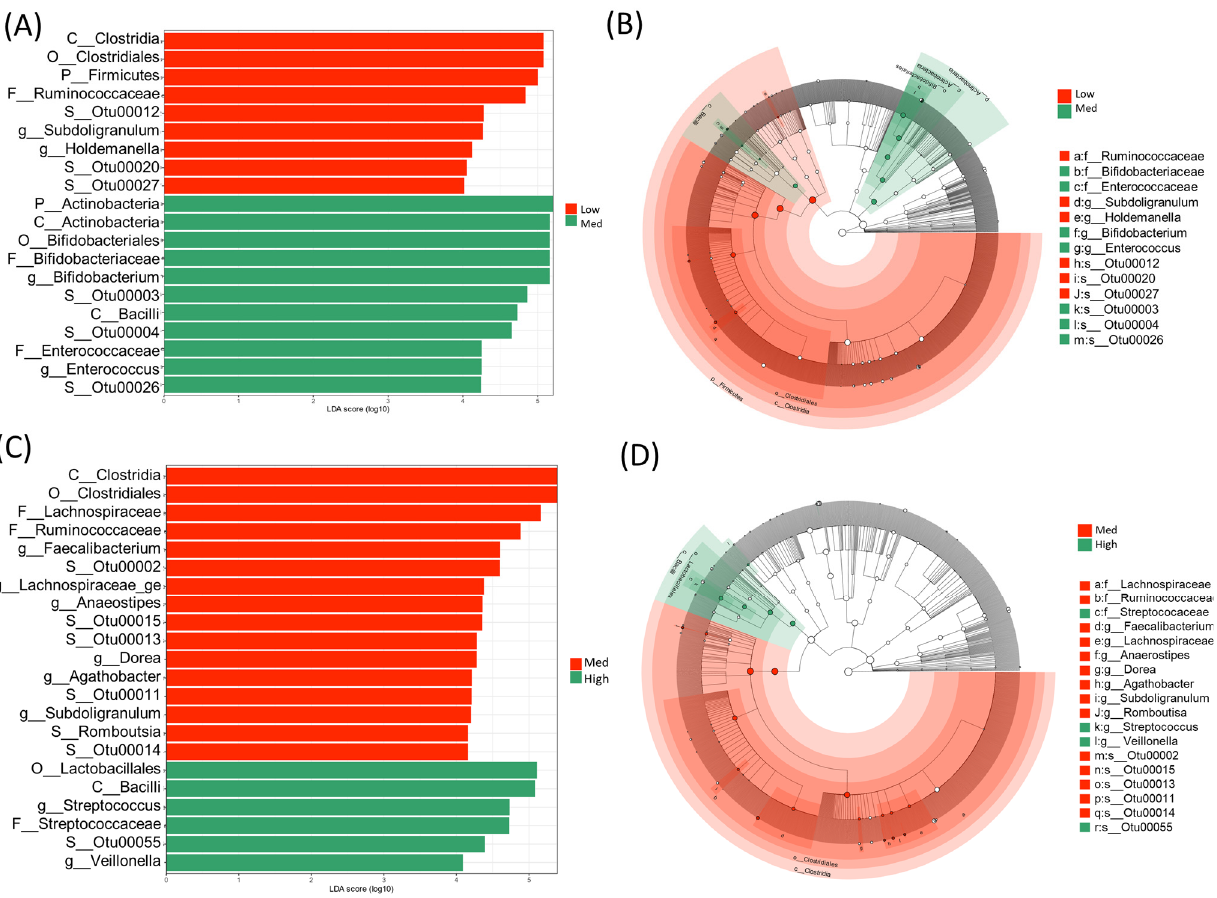
Figure 5. Linear discriminate analysis (LDA) effect size (LEfSe) showing the characteristics of the microbial community composition between the low- and medium-gamma-aminobutyric acid (GABA) groups in panels ( A , B ) as well as between the medium- and high-GABA groups in panels ( C , D ). ( A , C ) LEfSe (LDA scores 10 4 and more) displaying statistical and differentially abundant taxa in each group. ( B , D ) Cladogram showing the microbiome differences at different phylogenetic levels. The central point represents the root of the tree (bacteria) and each ring displays the next (lower) taxonomic rank (p__, phylum; c__, class; o__ order; f__, family; g__, genus). The diameter of each circle represents the relative abundance of each taxon.